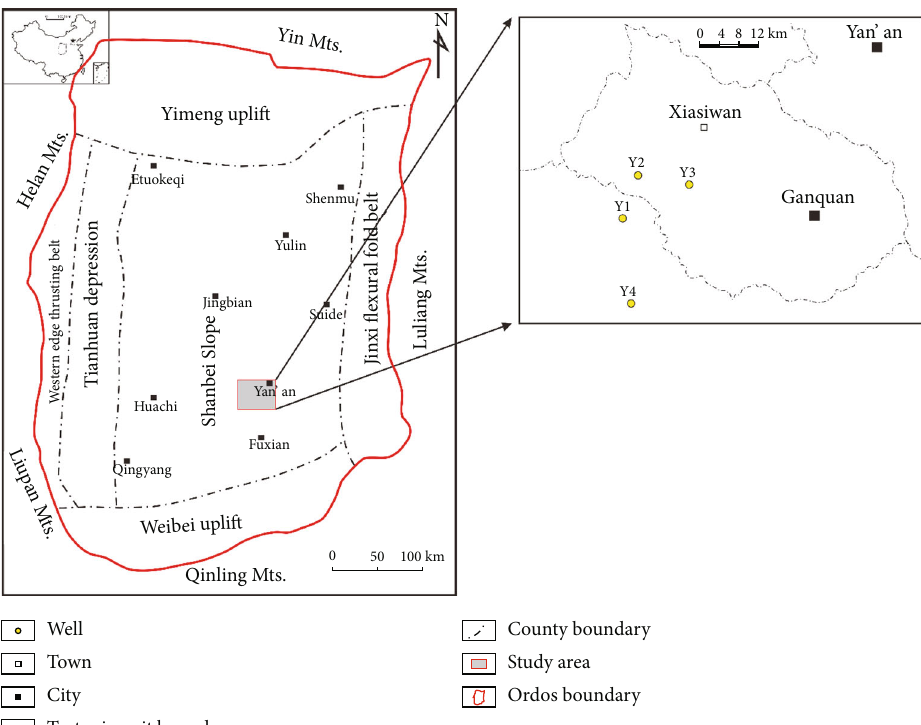
Figure 1: The location of Xiasiwan area in the tectonic units of Ordos Basin.